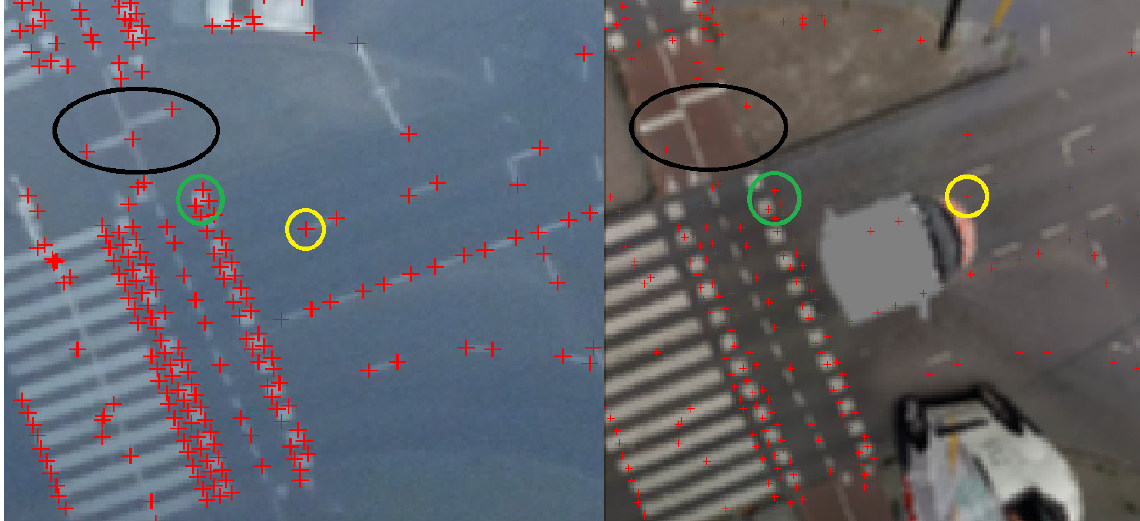
Figure 1. Left: aerial image with extracted Förstner keypoints; Right: aerial image’s keypoints back-projected into MM image. Coloured circles illustrate the horizontal error. Moreover, the ambiguity problem with repetitive road markings becomes apparent using the example of the green circle; three corners have been identified in the aerial image. The back-projected keypoints, however, are now closer to the adjacent square-shaped road marking which may lead to a wrong